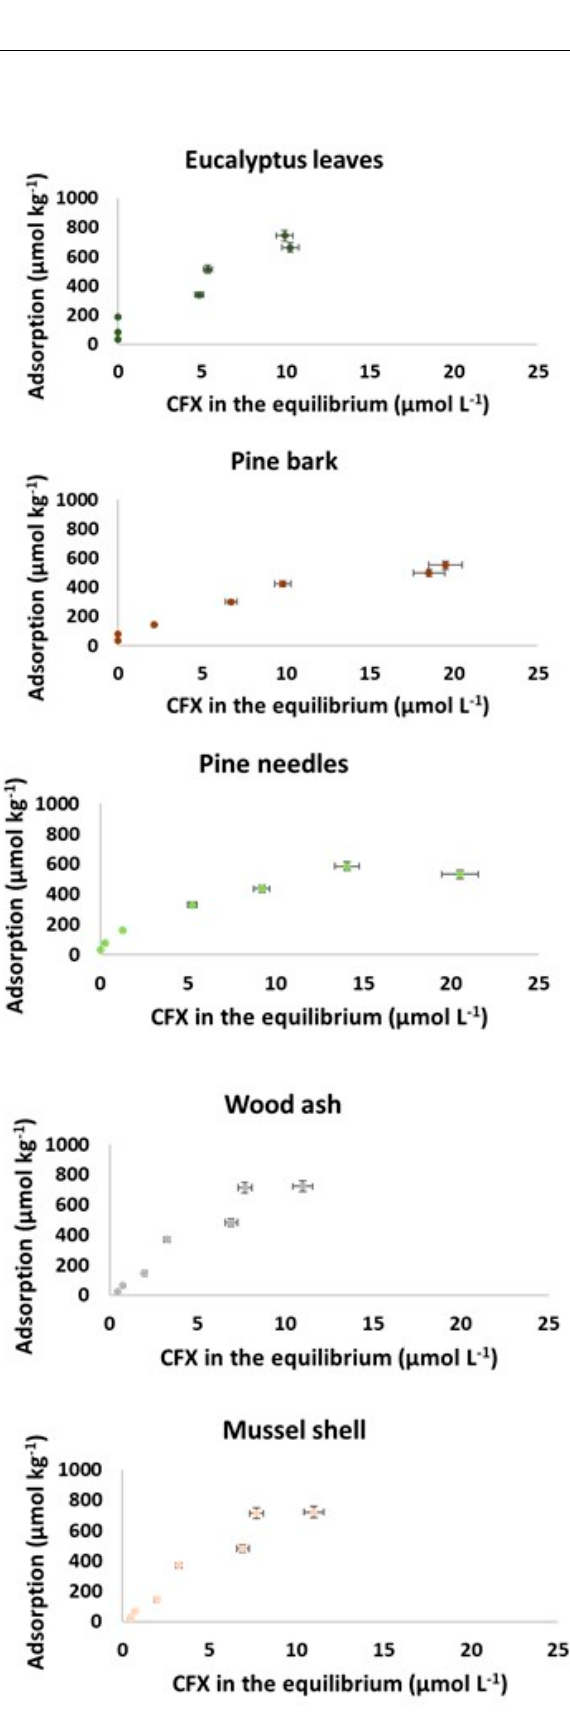
Figure 1. Adsorption curves for CFX and the five sorbent materials used. Comparing the results obtained for the different adsorbents, it is clear that the materials with the highest pH (mussel shell and wood ash) are those with the highest adsorption values, especially when the highest concentrations of the antibiotic are added. Similarly, Fakhri and Adami [30] pointed out that the parameter that most influences the